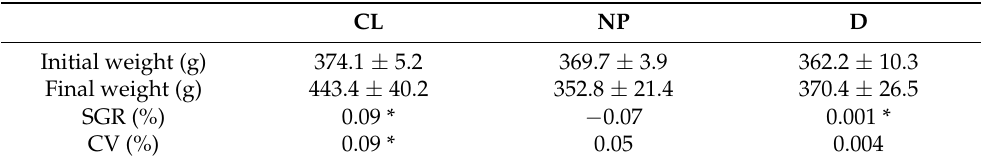
Table 1. Juvenile dusky grouper Epinephelus marginatus growth performance submitted to different experimental photoperiods after 50 days. Continuous darkness—D; normal photoperiod—NP; and continuous light—CL. SGR is growth rate; CV is coefficient of variation for